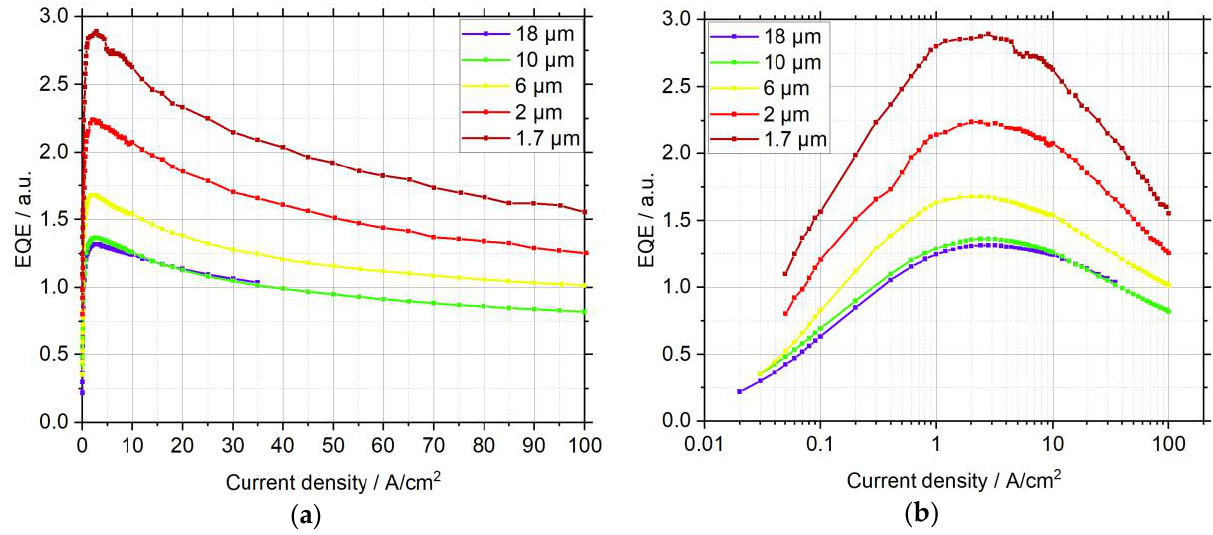
Figure 5. Size-dependent external quantum efficiency curves in arbitrary units displayed with ( a ) linear, and ( b ) semilogarithmic, scaling. The measured external quantum efficiency (EQE) increases with decreasing size, which can be explained by an increase of light extraction at the sidewall.